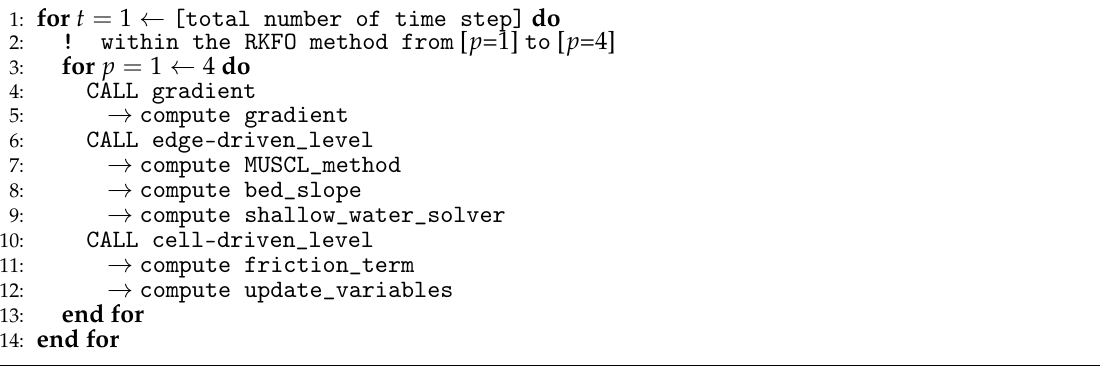
Algorithm 1 Typical algorithm for shallow water code (within the Runge–Kutta fourth-order (RKFO) method’s framework)